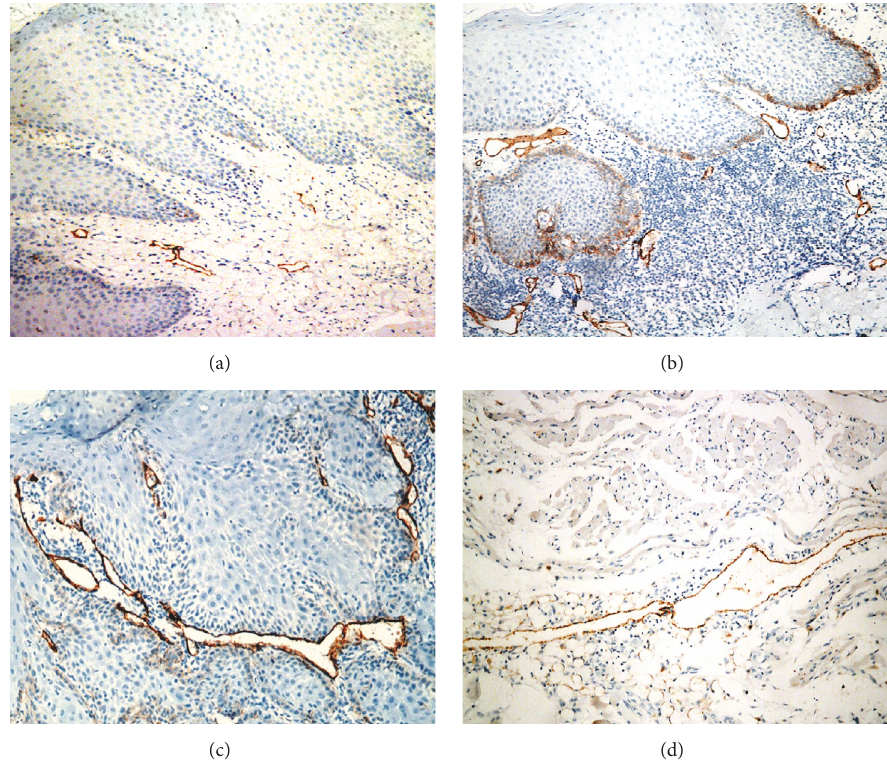
Figure 3: Photomicrographs of D2-40 stained sections showing few and superficially located LVs in normal mucosa ((a) × 200), more numerous LVs in node-free OSCC ((b) 200), and more dilated and deeply located LVs in positive lymph nodes OSCC ((c) × 200), ((d) ×